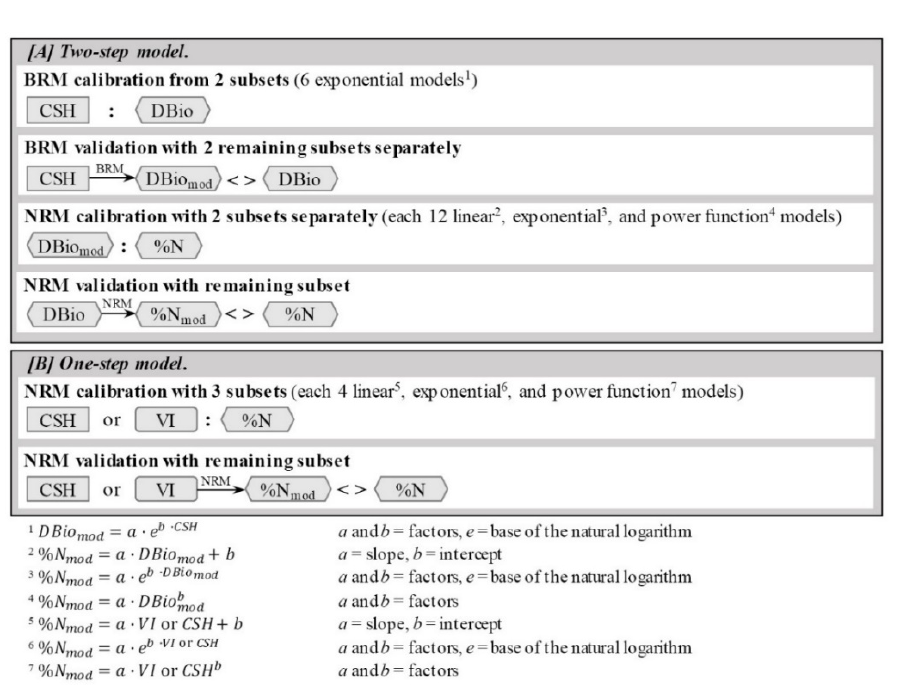
Figure 3. Concept of the two-step ( A ) and one-step ( B ) models (BRM: biomass regression model; NRM: nitrogen regression model; CSH: crop surface height; VI: vegetation index; DBio: dry biomass; DBio mod : modeled dry biomass; %N: nitrogen concentration; %N mod : modeled nitrogen concentration).